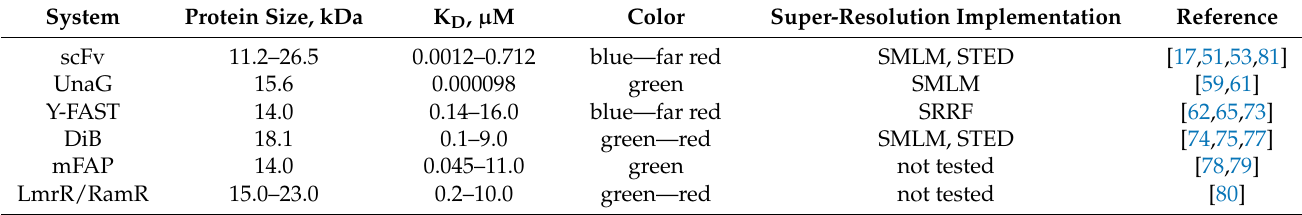
Table 1. Characteristics of existing labeling systems based on fluorogen-activating